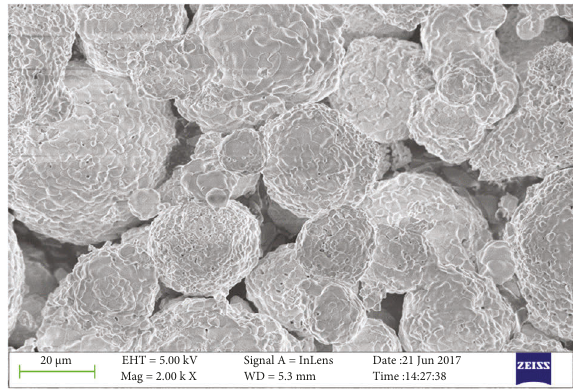
Figure 2: SEM image of yttria-stabilised zirconia powder used for thermal spray process.